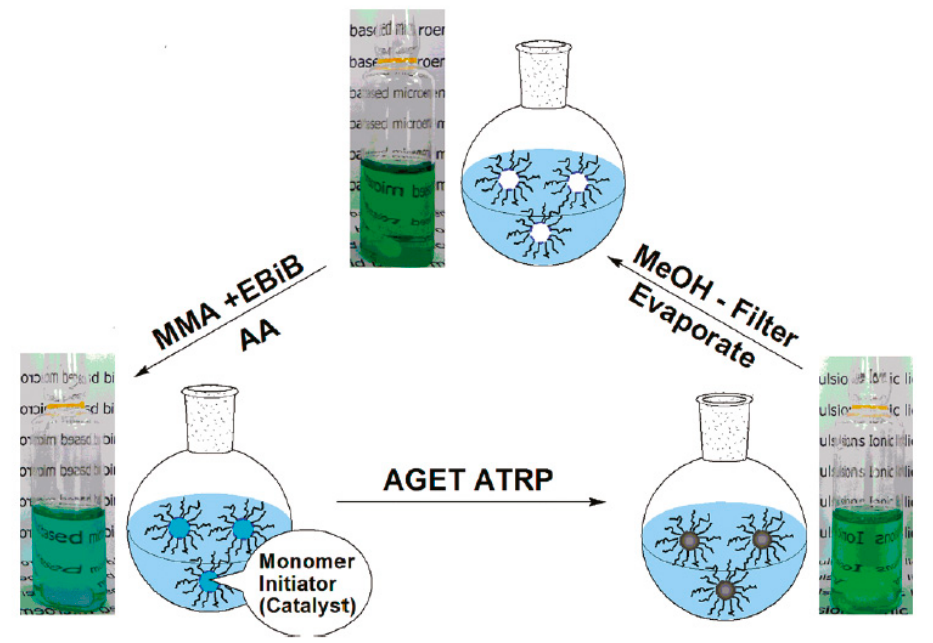
Figure 20. The complete cycle of activators regenerated by electron transfer- atom transfer radical polymerization) (AGET–ATRP) of MMA, polymer precipitation and microemulsion regeneration in the system C 12 C 1 ImBr/C 4 C 1 ImBF 4 /MMA. EBiB and AA refer to the polymerization initiator ethyl-2-bromo-isobutyrate and ascorbic acid, respectively [230]. Reprinted with permission from ref. [230]. Copright 2021 ACS